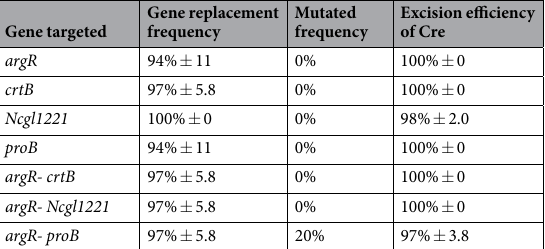
Table 2. RecET recombineering and Cre excision of different genes in C. glutamicum ATCC14067. 1 μ g targeted linear dsDNA cassettes were used for electroporation and each targeted gene with three experiments performed in parallel. The recovered colonies were analyzed by PCR using at least 10 colonies of each, in parallel, to identify the targeted gene replacement frequency. At least five recombinants were sequenced to identify the mutated frequency. Three or more correct recombinants were induced to explore the Cre excision